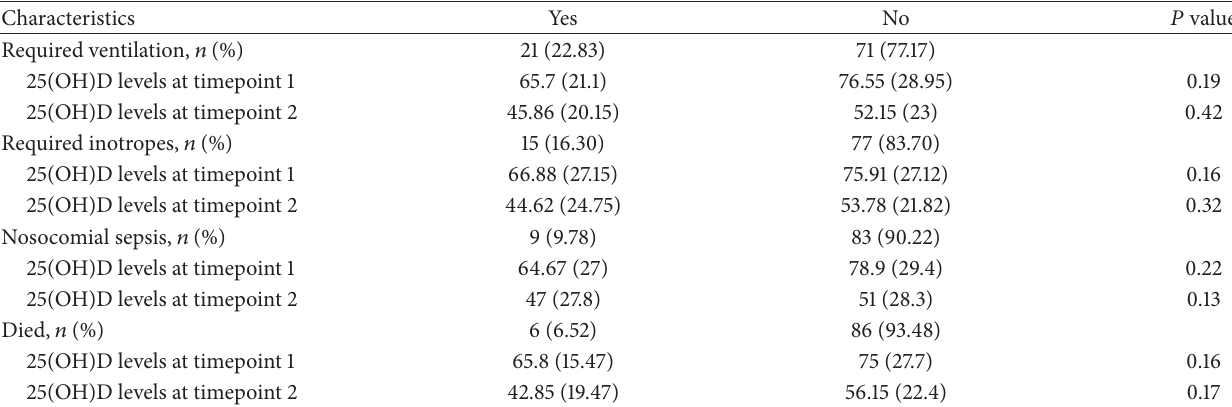
Table 4: Mean ( ± SD) 25(OH)D levels at timepoints 1 and 2 among patients who required ventilation and inotropes, those who developed nosocomial sepsis, and those who died versus those who did not. Characteristics